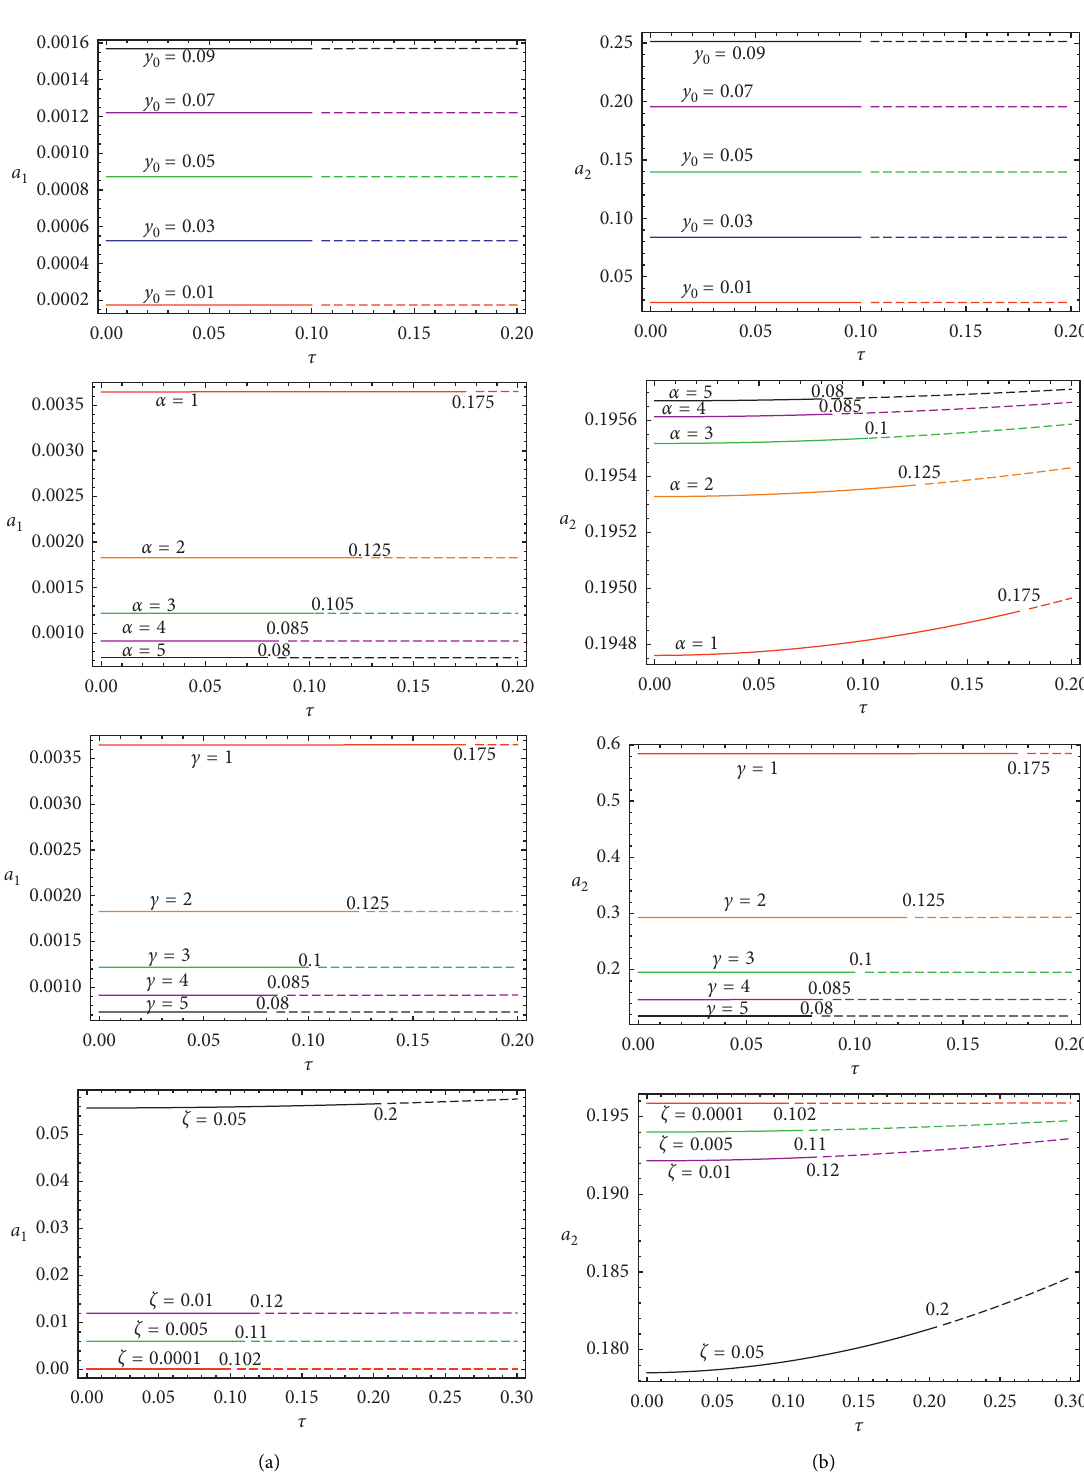
+ τ : (a) the main system; (b) the 1 2